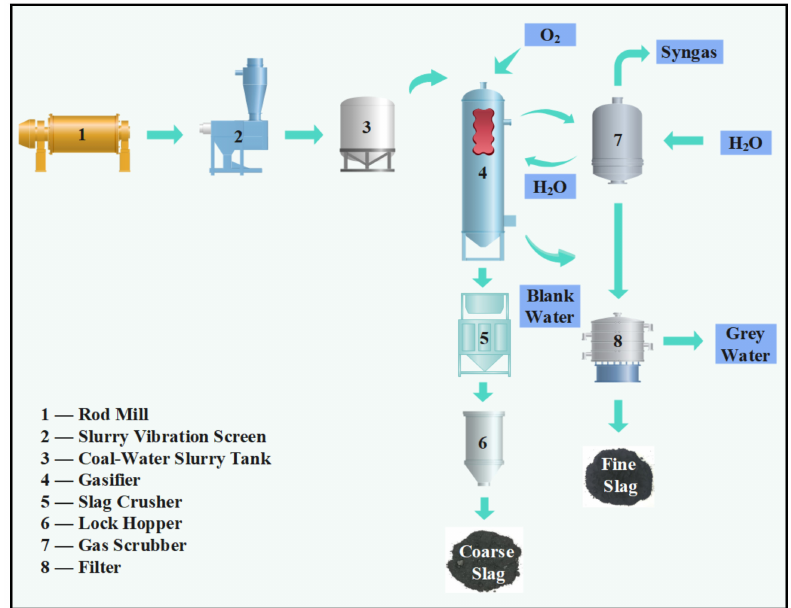
Figure 1. Schematic diagram of the coal gasification process